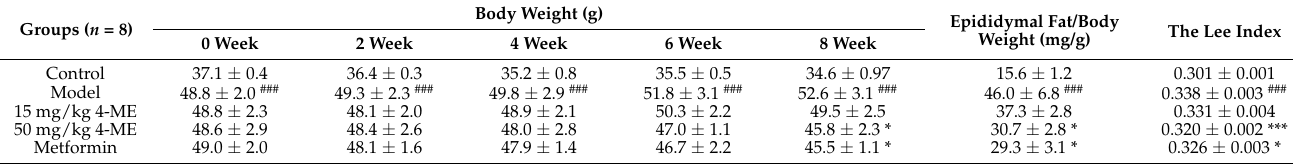
Table 1. Effects of 4-ME upon physiological parameters in HFD-fed